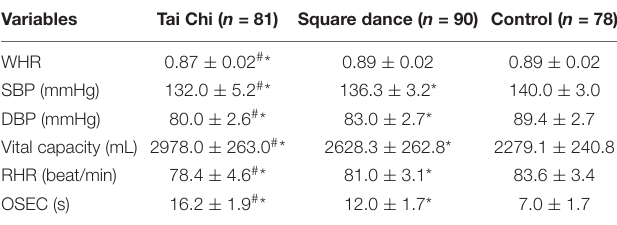
TABLE 3 | Physical health of the participants in the three groups ( n = 249).